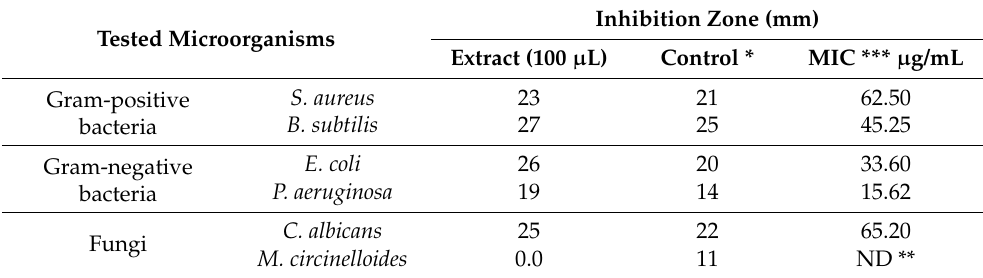
Table 3. Antimicrobial activity of M. pulegium